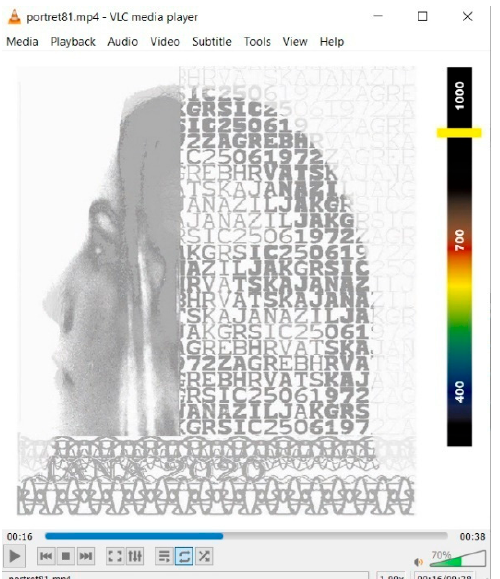
Figure 18. Blockage at 850 nm.